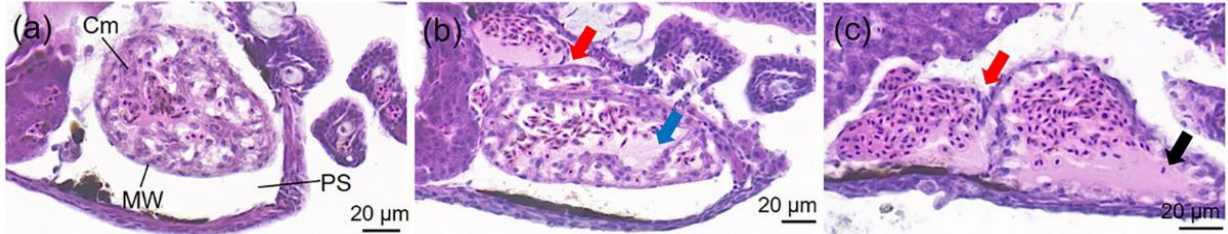
Figure 3. Histology (longitudinal section) of O. melastigma (McClelland, 1839) heart after 96 h of exposure to ( a ) control, ( b ) 9.53% WAF and ( c ) 55.56% WAF. PS: pericardial sac; Cm: cardiomyocyte; MW: myocardial wall. The typical histopathological alterations of heart were characterized with different symbols: cardiac malposition (red arrow), decrease in cardiomyocyte (blue arrow) and dilatation of heart (black